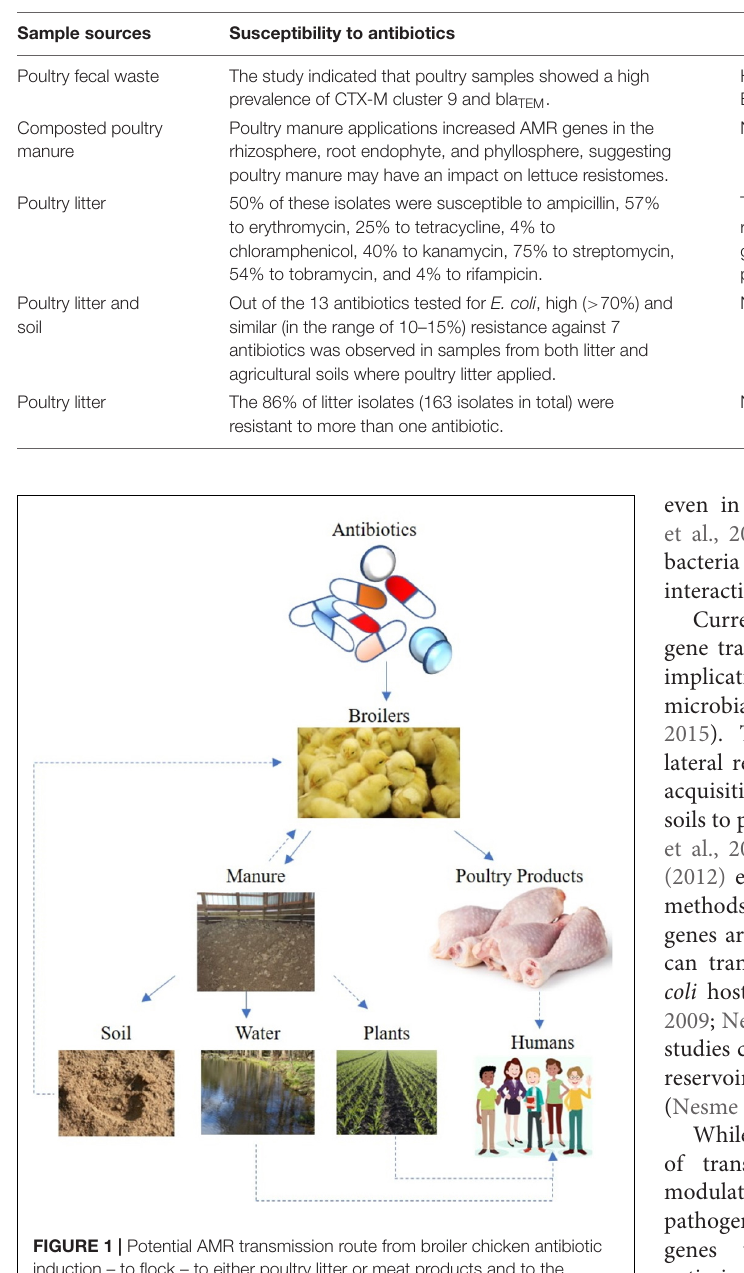
TABLE 1 | Sample sources, susceptibility to antibiotics, and mechanisms of potential AMR gene transfer to the environment.